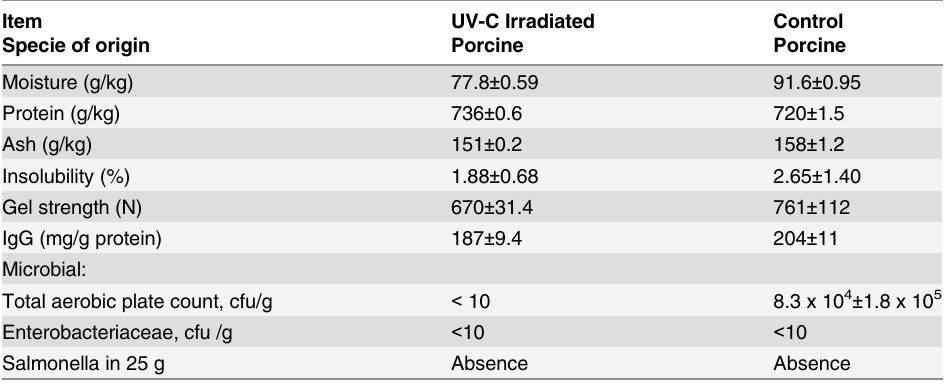
Table 1. Chemical and microbial analyses of spray dried porcine plasma used in Experiment 2 (as-fed basis). Results are expressed as average ±